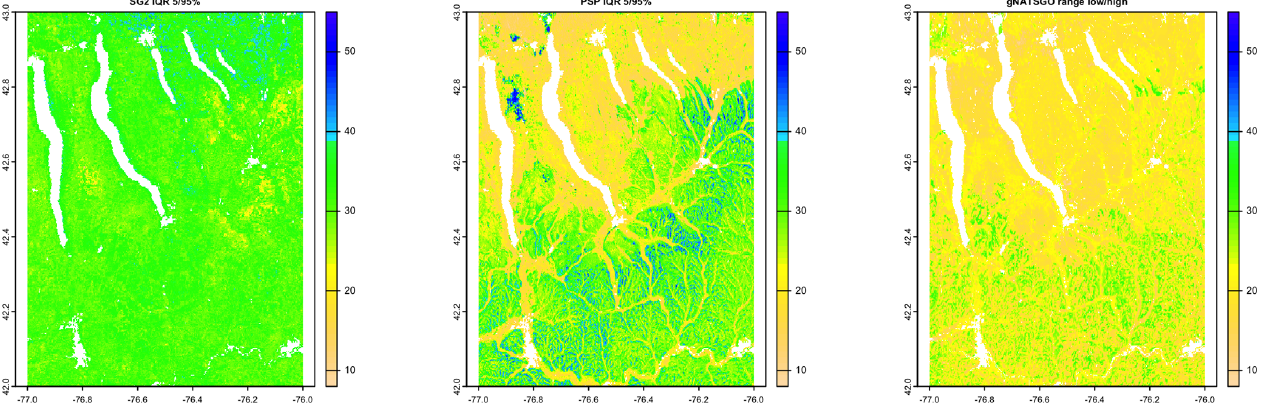
Figure 12. Interquartile ranges at 0.05–0.95 for pH × 10 at 0–5cm. The SG2 IQR is fairly consistent, from about 2.5 to 3.5pH. The PSP IQR has a wider range and more spatial patterning. The gNATSGO low–high range is